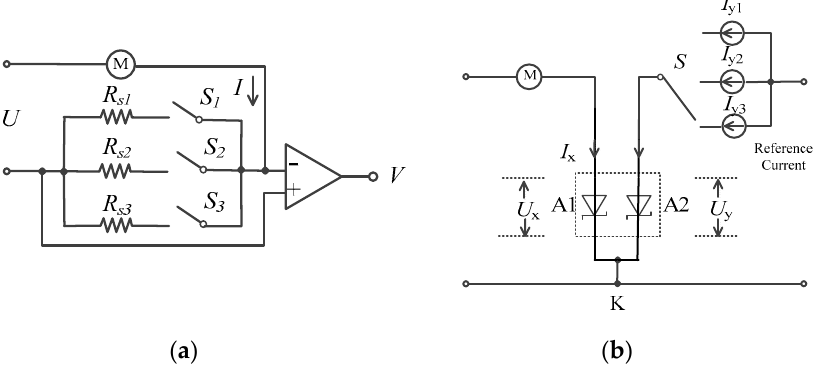
Figure 6. ( a ) Conventional current measuring circuit, and ( b ) twin-device-based continuous current measuring circuit.